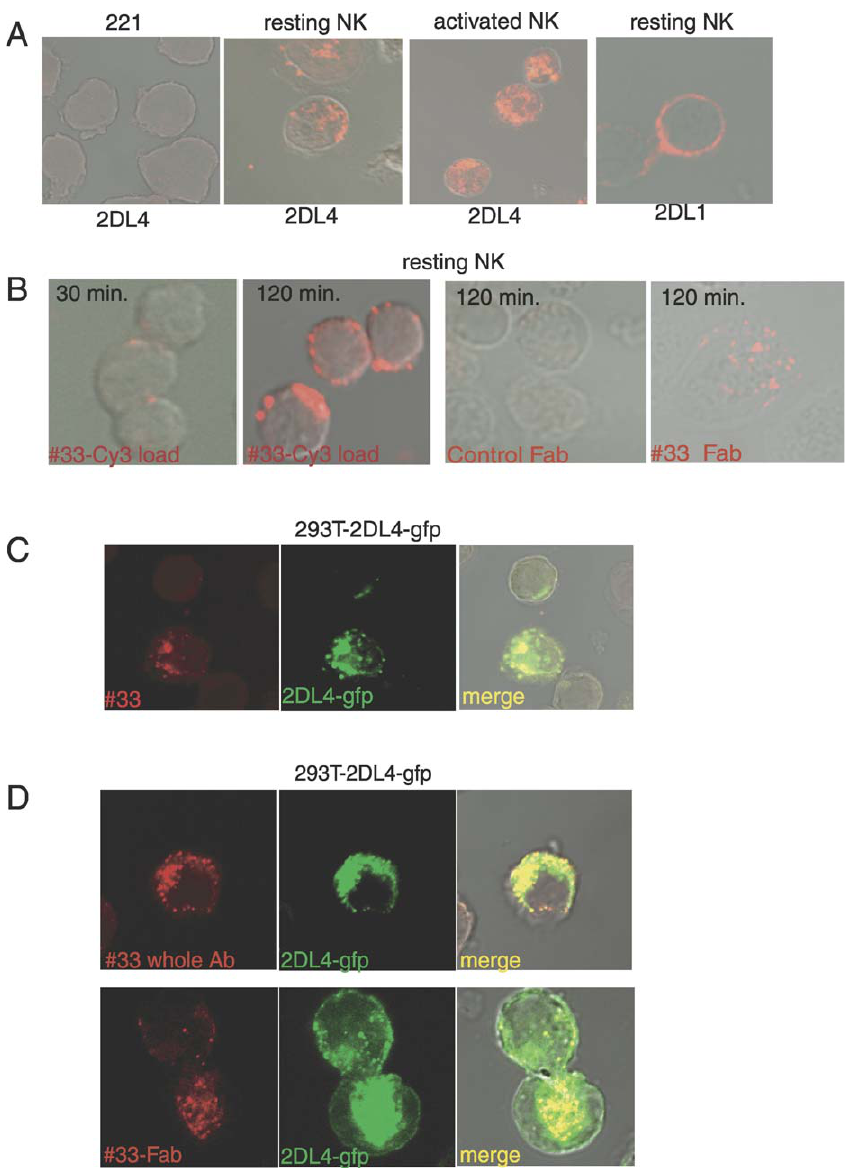
Figure 2. KIR2DL4 Is Endocytosed into Intracellular Vesicles (A) The B cell line 721.221 (221), resting NK cells, and activated NK cells were fixed, permeabilized, and stained with Cy3-conjugated mAb 33. In the image on the right, resting NK cells were fixed, permeabilized, and stained with a polyclonal antibody specific for the tail of KIR2DL1, followed by Alexa-